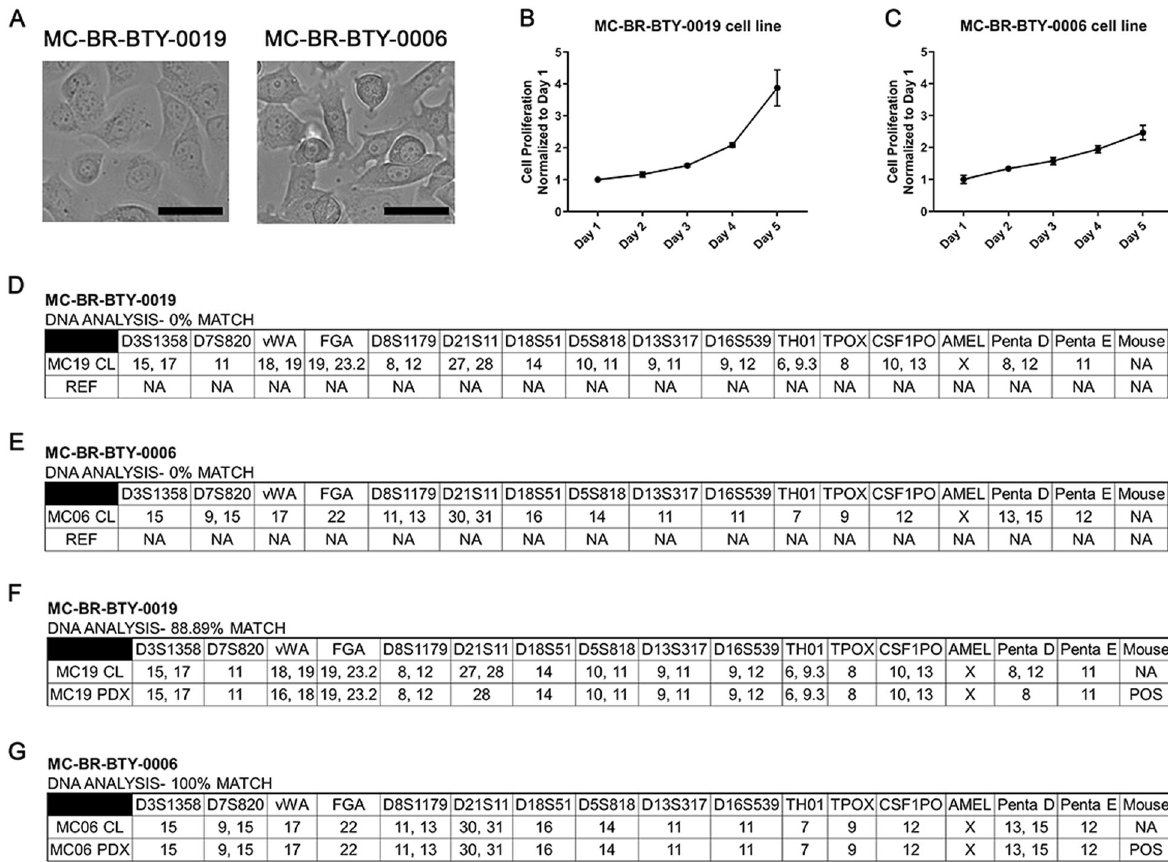
Fig. 1 Established cell lines are unique breast cancer cell lines. A The images of MC-BR-BTY-0019 and MC-BR-BTY-0006 were presented after they were established as immortalized cell lines. Images were taken at ×20; Scale bar represents 20 μ m. B , C 30,000 cells and 85,000 cells were plated onto 24-well plates for the proliferation assay for MC-BR-BTY-0019 and MC-BR-BTY-0006, respectively. The proliferation curves are normalized to day 1. Error bars represent SEM. DNA analysis of D MC-BR-BTY-0019 cell line, E MC-BR-BTY-0006 cell line, F MC-BR-BTY-0019 PDX, and G MC-BR-BTY-0006 PDX was demonstrated by STR pro fi ling. REF refers to allele comparisons to all cell lines available in ATCC, DSMZ, JCRB STR pro fi le databases. “ NA ” designates no similar allele calls compared to the